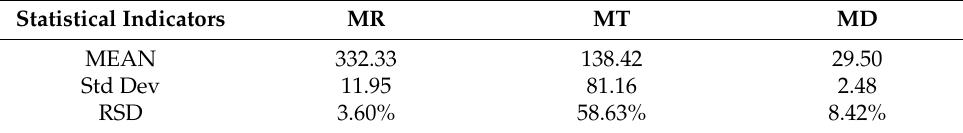
Table 3. Relative standard deviation (RSD).